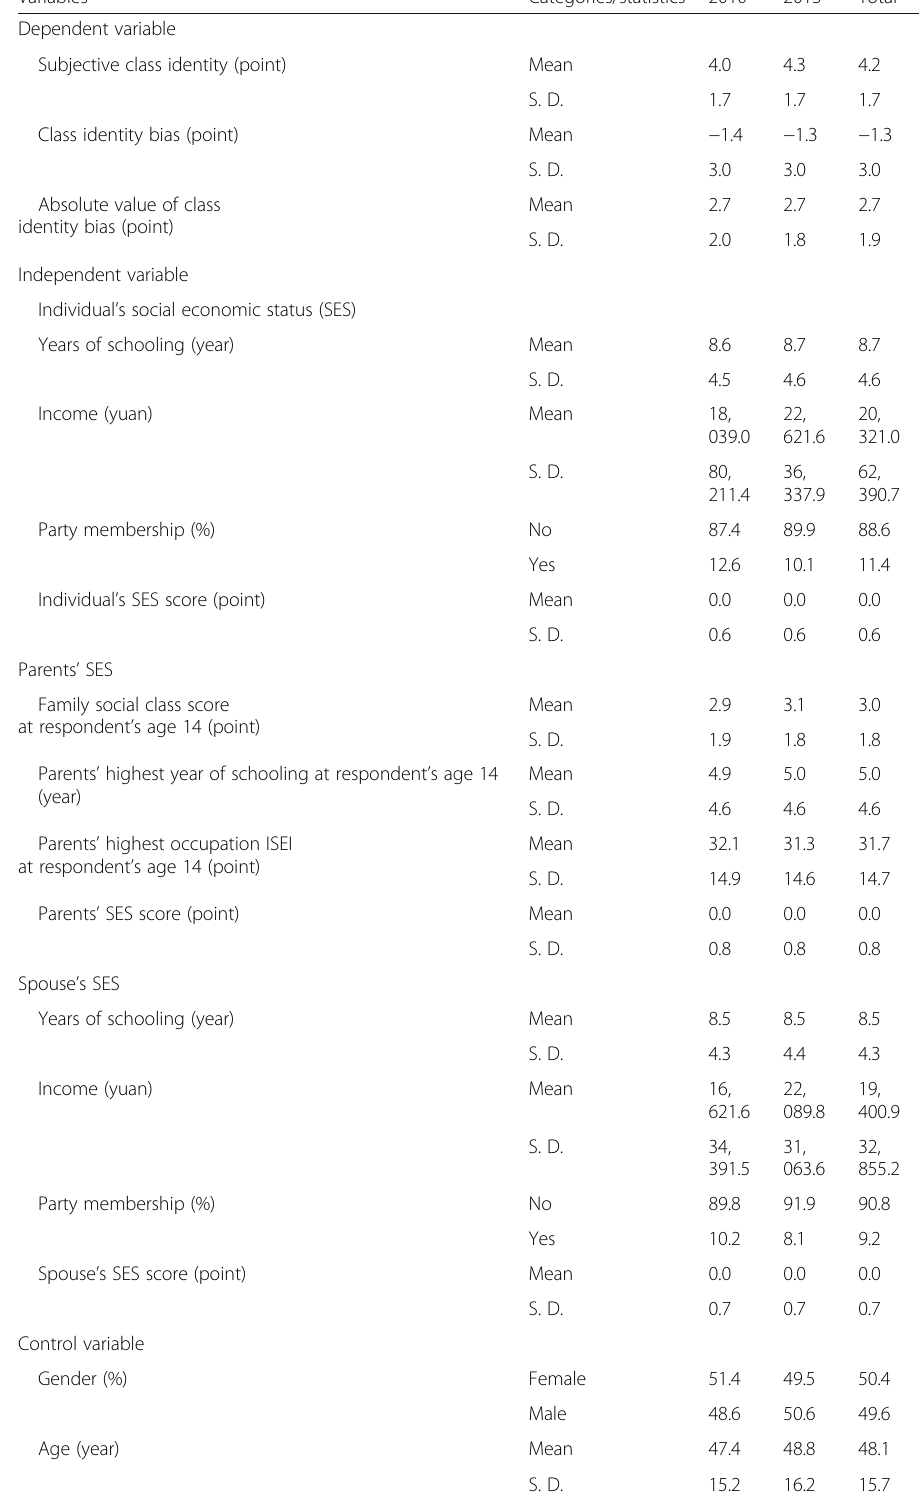
Table 2 Descriptive statistics for each